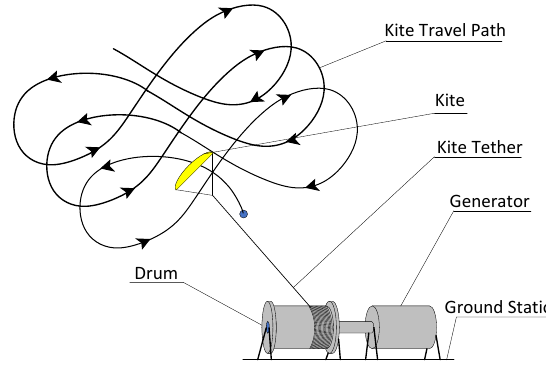
Figure 1. Kite power generation technique: kite travels in a figure-eight trajectory, which pulls the tether wound on the drum and rotates the generator to produce electric power The nonlinearity in the kite power system makes tether force estimation complex using mathematical models. Deep Neural Networks (DNNs) offer a great solution to nonlinear problems in many applications [19]. Researchers have explored methods for